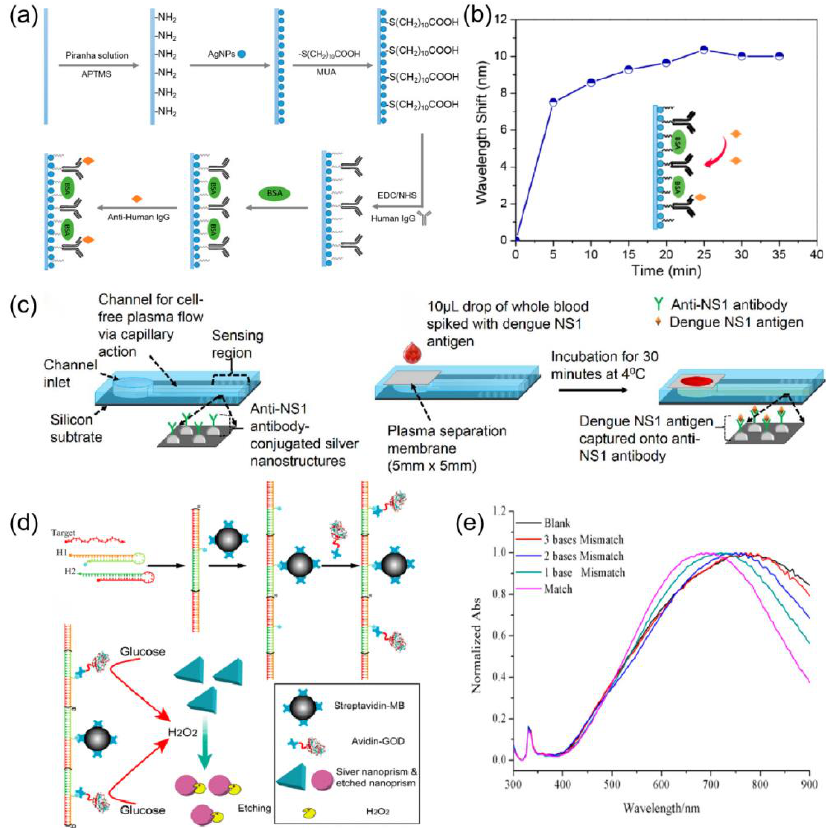
Figure 11. ( a ) Schematic of bio-sensing approaches using the Ag NPs-based LSPR sensor probe. Reprinted with permission from Ref. [127]. Copyright 2015, Sensors. ( b ) LSPR peak wavelength changes during the process of anti-human IgG immobilization on the Ag NP-based sensor surface over a period of 35 min. Reprinted with permission from Ref. [127]. Copyright 2015, Sensors. ( c ) Schematic of the biosensor used with on-chip separation and detection of NS1. Reprinted with permission from Ref. [128]. Copyright 2019, Biosensors and Bioelectronics. ( d ) Construction of HCR-based specific DNA detection platform. The sensing mechanism is based on the etching process of triangular silver nanoprisms. Reprinted with permission from Ref. [129]. Copyright 2014, ACS Nano. ( e ) Specificity of the DNA detection. UV-vis spectra of triangular silver nanoprisms in the presence of target DNA (10 nM) with different mismatched bases. Reprinted with permission from Ref. [129].